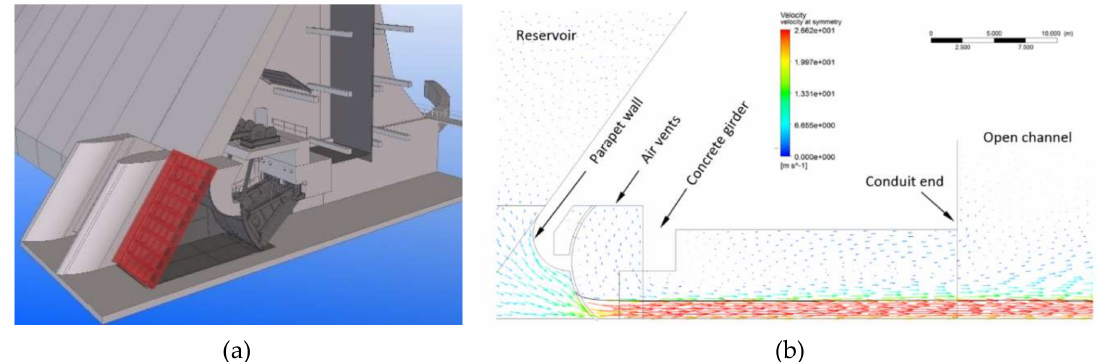
Figure 9. Bottom outlet at Storfinnforsen dam: ( a ) Layout; ( b ) CFD results of two-phase